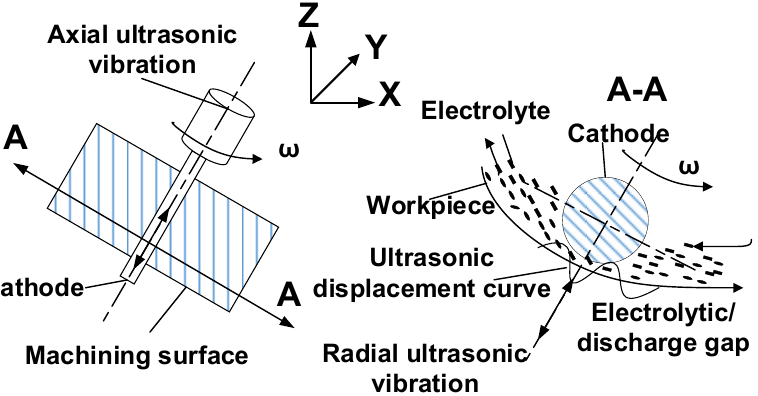
Figure 1. Mechanism of multi-dimensional rotational ultrasonic combined electrochemical formation machining.